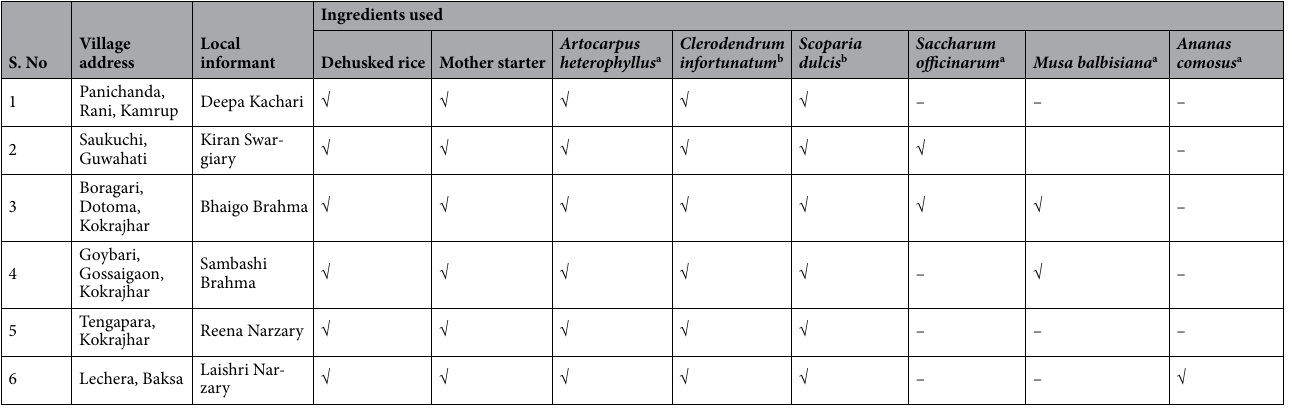
Table 1. List of emao samples collected from different Bodo villages of Assam. Tick (√) mark represents present and dash (–) mark represents the absence of the ingredient. The use of Artocarpus heterophyllus and Clerodendrum infortunatum along with rice powder and mother starter is common, whereas the other herbs are used alternatively depending on the availability of the plants at the time of emao preparation. a Leaves are used. b Leaves or twigs containing leaves and flowers are used.